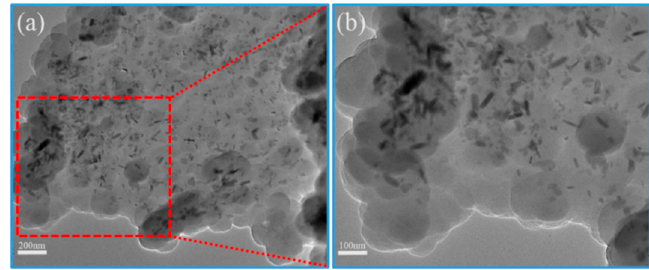
ff erent magnification TEM images of ( a , b ) rGO / CuS / PPy Figure 3. Different magnification TEM images of ( a , b ) rGO/CuS/PPy sample. Figure 3. Di Figure 3. Different magnification TEM images of ( a , b ) rGO/CuS/PPy sample.